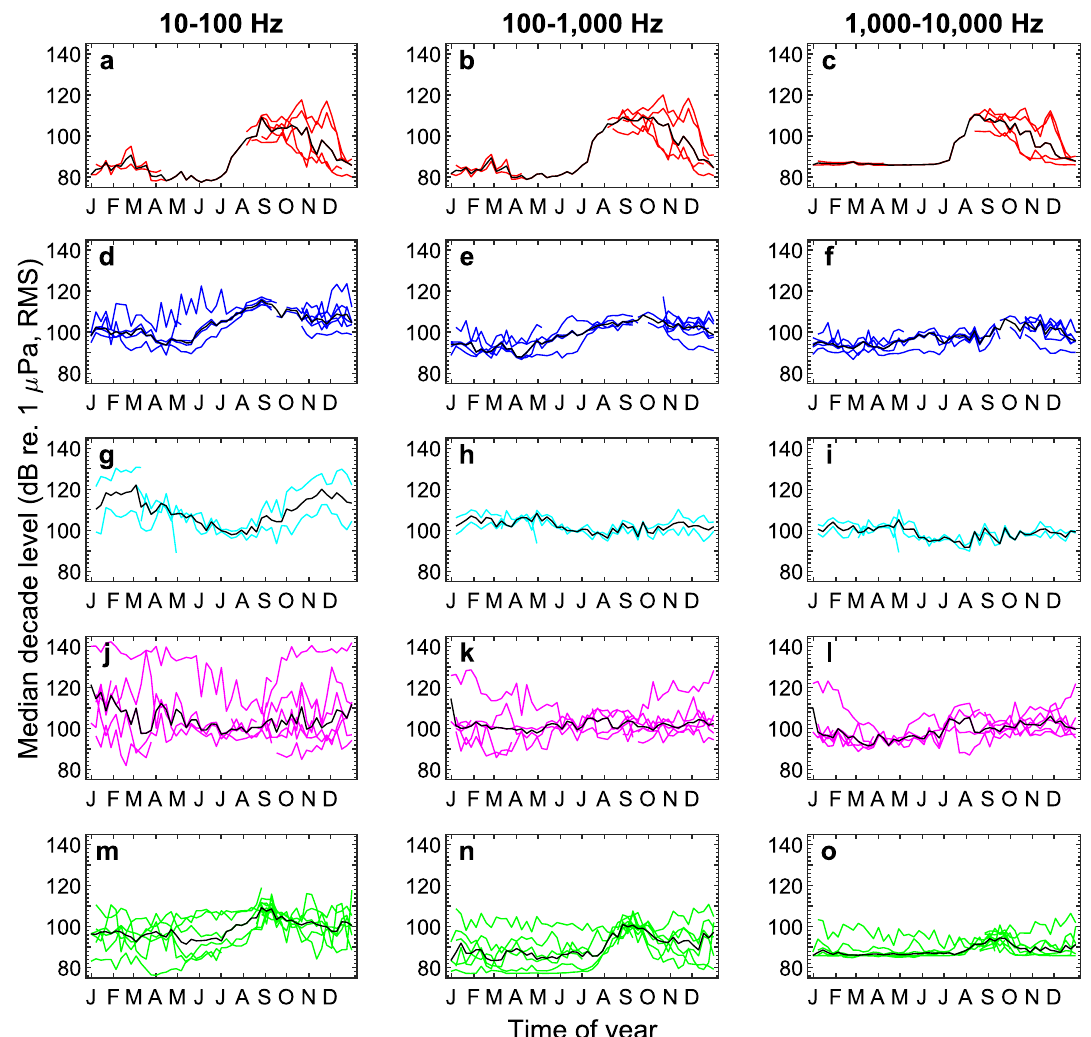
Figure 5. Seasonal and regional (asynchronous) variation of ambient noise levels summarized as weekly median levels. The weekly median decade levels are plotted for each station for each of the five geographic regions: Melville Bay ( a – c ), Baffin Bay ( d – f ), South Greenland ( g – i ), Tasiilaq ( j – l ), and Greenland Sea ( m – o ) in the decade bands 10–100 Hz (VLF, first column), 100–1000 Hz (LF, second column), and 1–10 kHz (MF, third column). Black lines show the median for all data in each subplot. Note that the transition from December to January results in an additional line being plotted for each station. Self-noise has likely affected some noise estimates particularly in the MF band. For recordings exceeding a duration of 1 year, some weekly medians are based on data from the same weeks in different years. Region colours as in Fig. 1 (Melville Bay: red, Baffin Bay: blue, South Greenland: cyan, Tasiilaq: magenta, Greenland Sea: